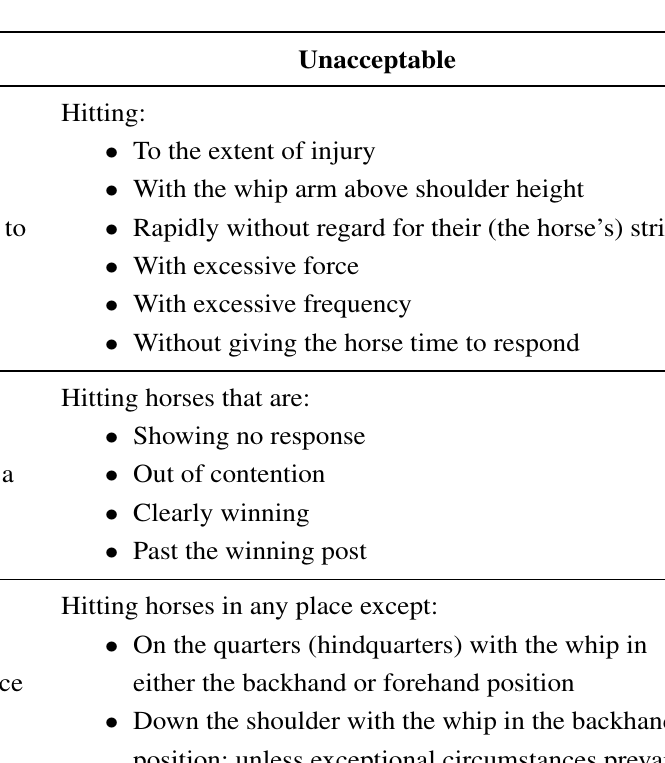
Table 1. Verbatim instructions on acceptable and unacceptable use of the whip in the BHA rules (BHA,